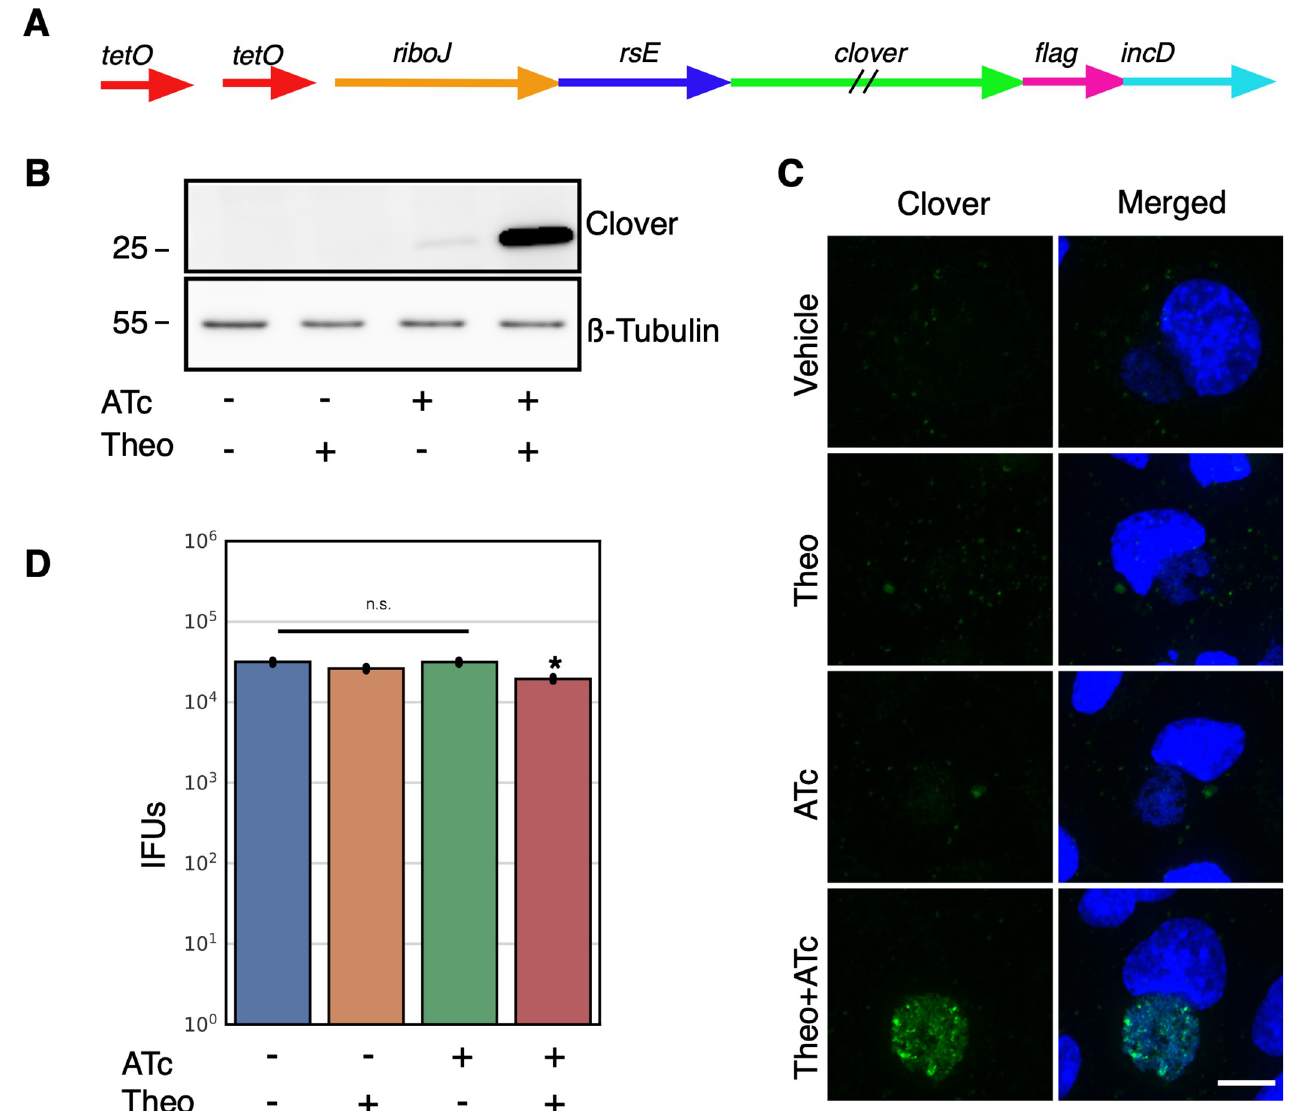
Fig 3. Characterization of p2TK2-SW2-Tetp-riboJ-E-clover-flag. A) Schematic of the Tet-riboJ-E-clover-flag construct consisting of the tet repressor, tet promoter, riboJ insulator, riboE riboswitch (rsE) and the ORF for the clover fluorescent protein containing an inframe 3x flag tag. B) Anti-flag western blot of Cos-7 cells infected with L2-Tet-J-E-clover-flag comparing expression of theophylline treated and untreated cultures. Cells were induced with 0.5 mM theophylline, 30ng/ml aTc, both aTc and theophylline or vehicle only at 16 hpi and proteins were harvested at 30 hpi. An anti-ß-tubulin I western blot served as a loading control. C) Confocal micrographs of Cos-7 cells infected with L2-Tet-J-E-clover-flag, induced with 0.5 mM theophylline, 30ng/ml aTc, both aTc and theophylline or vehicle only at 16 hpi and fixed and stained with DAPI (blue) for confocal microscopy at 30 hpi. Clover expression (green) was evident in cells treated with aTc and Theophylline. Size bar = 10 μ m. D) Cos-7 cells were infected with L2-Tet-J-E-clover-flag and the production of infectious progeny was determined at 48 hpi after induction with 0.5 mM theophylline, 30ng/ml aTc, both aTc and theophylline or vehicle only at 16 hpi. Production of infectious progeny was determined using a reinfection assay. Asterisk denotes p-value < 0.05. Error bars = SEM. https://doi.org/10.1371/journal.pone.0257259.g003 upstream sequences, eliminating the promoter-associated RNA leader (S2 Fig). This resulted in transcripts with a small hairpin region just upstream of the E riboswitch that we hypothe- sized would not affect the aptamer function of the riboswitch. We used this same regulatory scheme to control the expression of both Clover and HctB resulting in plasmids p2TK2-SW2-Tet-J-E-clover-3xflag and p2TK2-SW2-Tet-J-E-hctB-3xflag. For the HctB clone